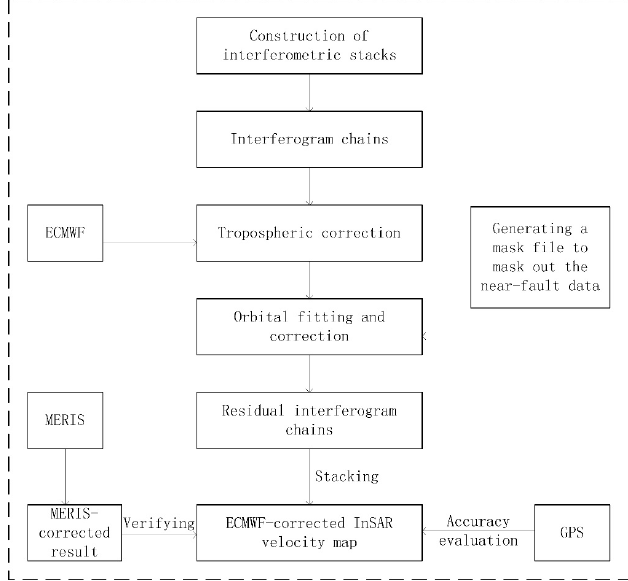
Figure 2. A flowchart for stacking interferometric synthetic aperture radar (InSAR) with atmospheric- corrected